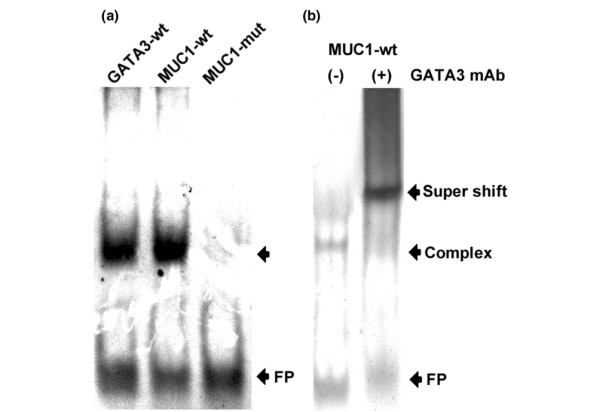
Electrophoretic mobility-shift assay employing cell nuclear extract from MCF7. (a) Gel shift analyses were performed with double-stranded oligonucleotides (27 bp) as indicated: positive control probe containing the GATA3-binding element (GATA3-wt), a mimetic wild-type MUC1 probe containing the predictive GATA3-binding site (MUC1-wt), and a probe sequence with predictive GATA3-binding site mutations (MUC1-mut). (b) The presence of GATA3 was confirmed by supershift assay. Nuclear extract prepared from MCF7 cells was preincubated with GATA3 antibody, and then incubated with the mimetic wild-type MUC1 probe containing the GATA3-binding site (MUC1-wt). Arrows to the right indicate the position of the free probe (FP), the probe–nuclear-protein complex (Complex), and the specifically retarded protein–GATA3-antibody–probe complex (Supershift).